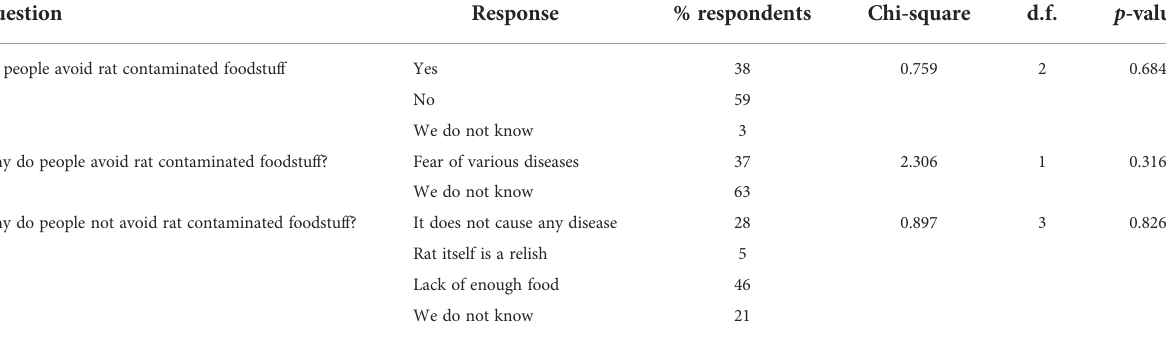
TABLE 4 Attitudes and practices of the respondents in Lilongwe towards food contaminated by rodents.